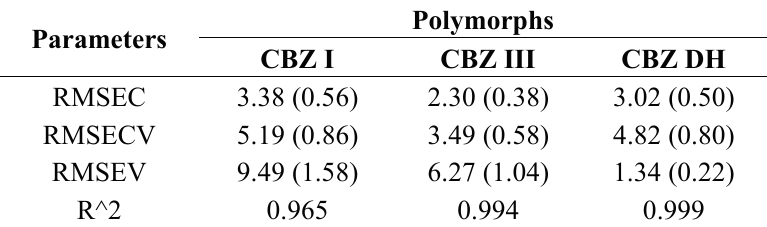
Table 1. Parameters for iPLS model for Raman spectroscopy (%